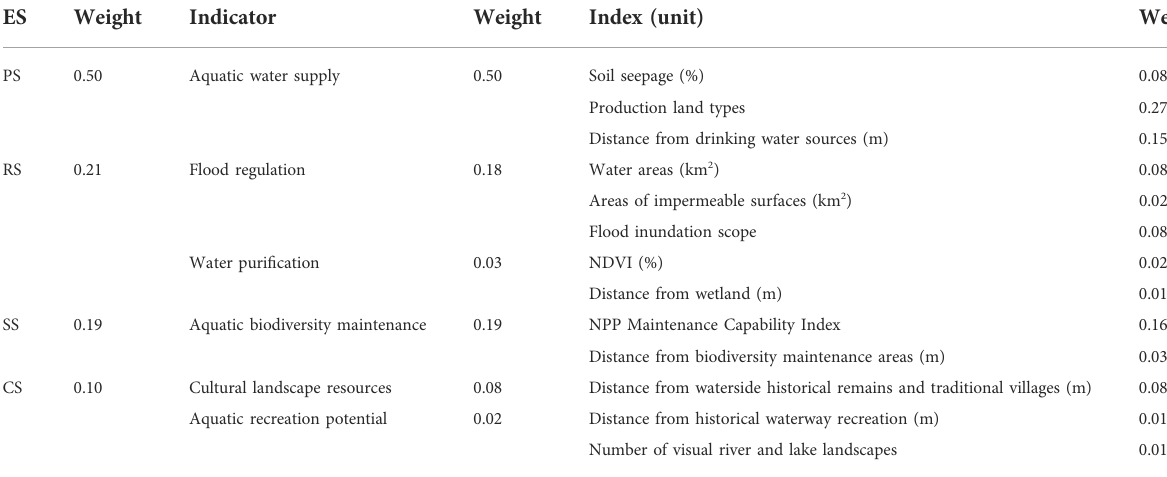
TABLE 3 Classi fi cation and weight of aquatic ES supply